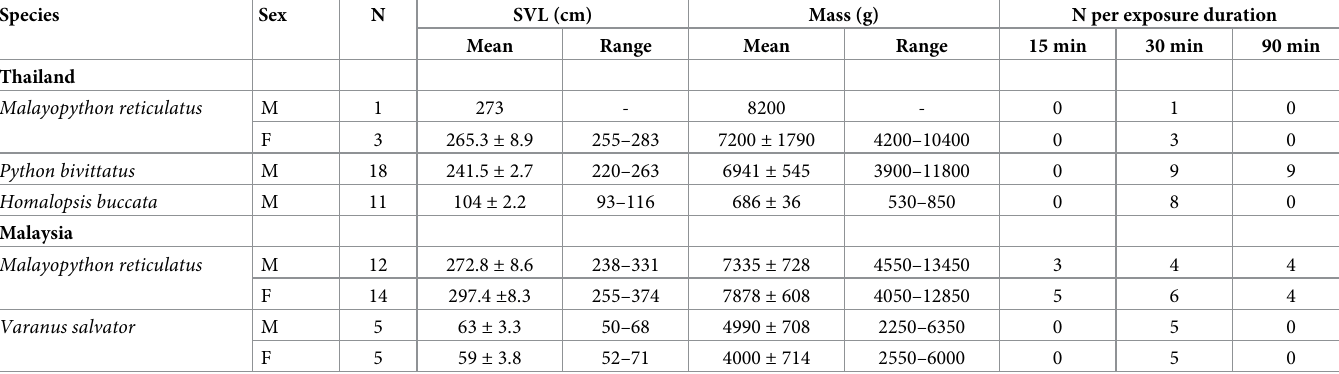
Table 1. Means, standard errors and ranges for snout-vent length (SVL) and body mass for reptile specimens used to examine behavioral responses to CO 2 exposure.